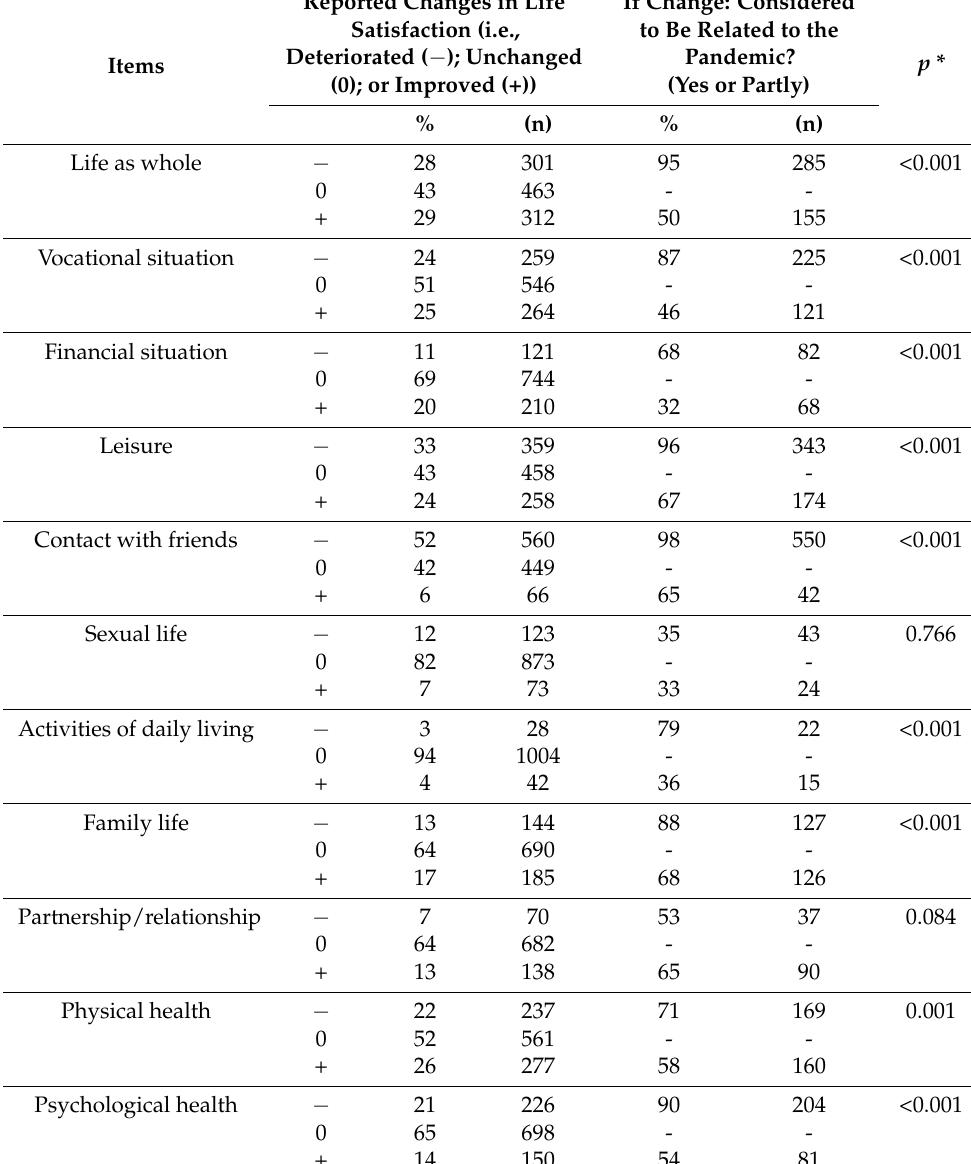
Table 3. Reported change in life satisfaction with different aspects of life (LiSat-11) compared to the same period last year, and whether perceived change was experienced due to the COVID-19 restrictions (n =